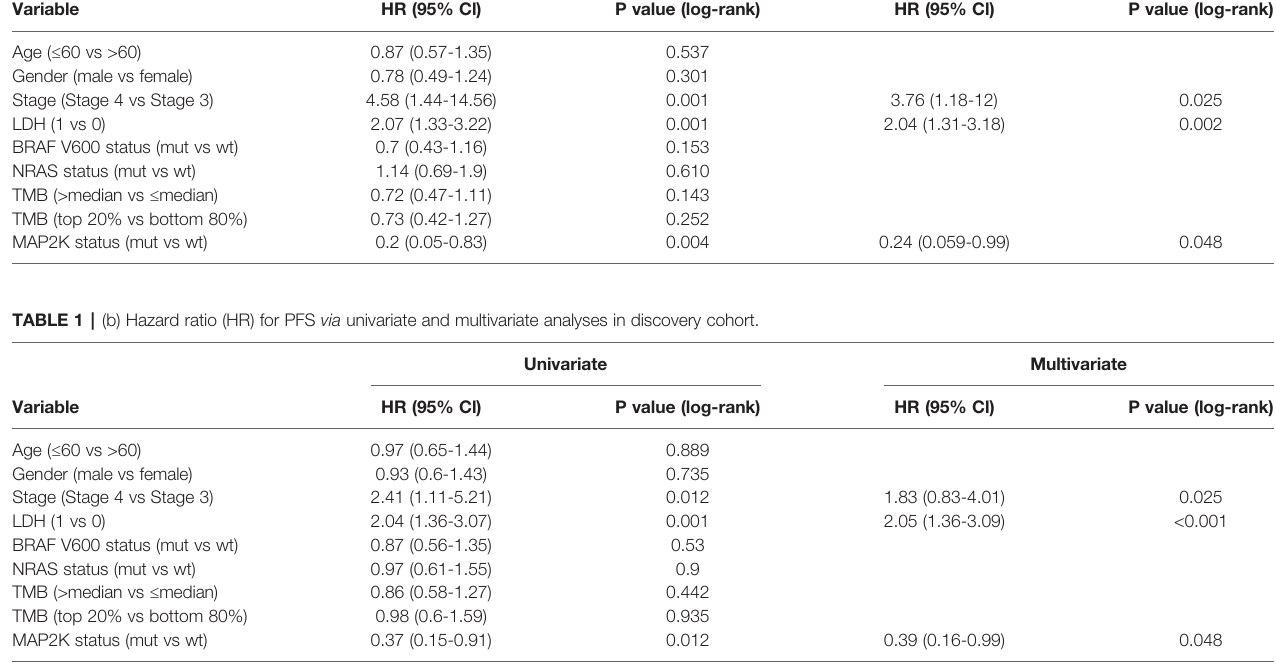
TABLE 1 | (a) Hazard ratio (HR) for OS via univariate and multivariate analyses in discovery cohort. Univariate Multivariate